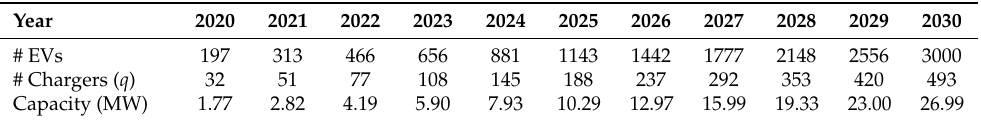
Table 1. The estimated number of 7 kW chargers and available VGI capacity in 2020–2030 (in thousands, MW).